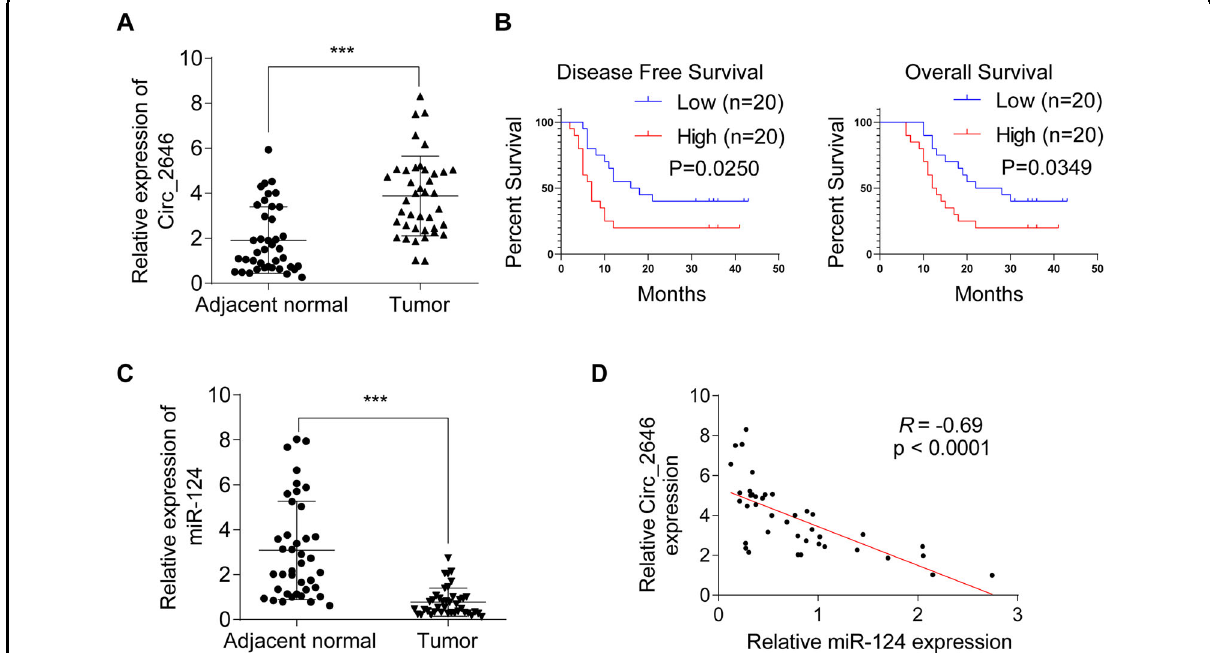
Fig. 1 Three predicted circRNAs targeting miR-124 in ESCC. A The expression of CircRNA_2646 in ESCC tissues and adjacent normal tissues ( n = 40) determined by RT-qPCR. p < 0.0001. B The correlation of the CircRNA_2646 expression and disease-free survival and overall survival of patients. p < 0.05. C The expression of miR-124 in ESCC tissues and adjacent normal tissues determined by RT-qPCR. D Correlation of CircRNA-2646 expression and miR-124 expression in ESCC